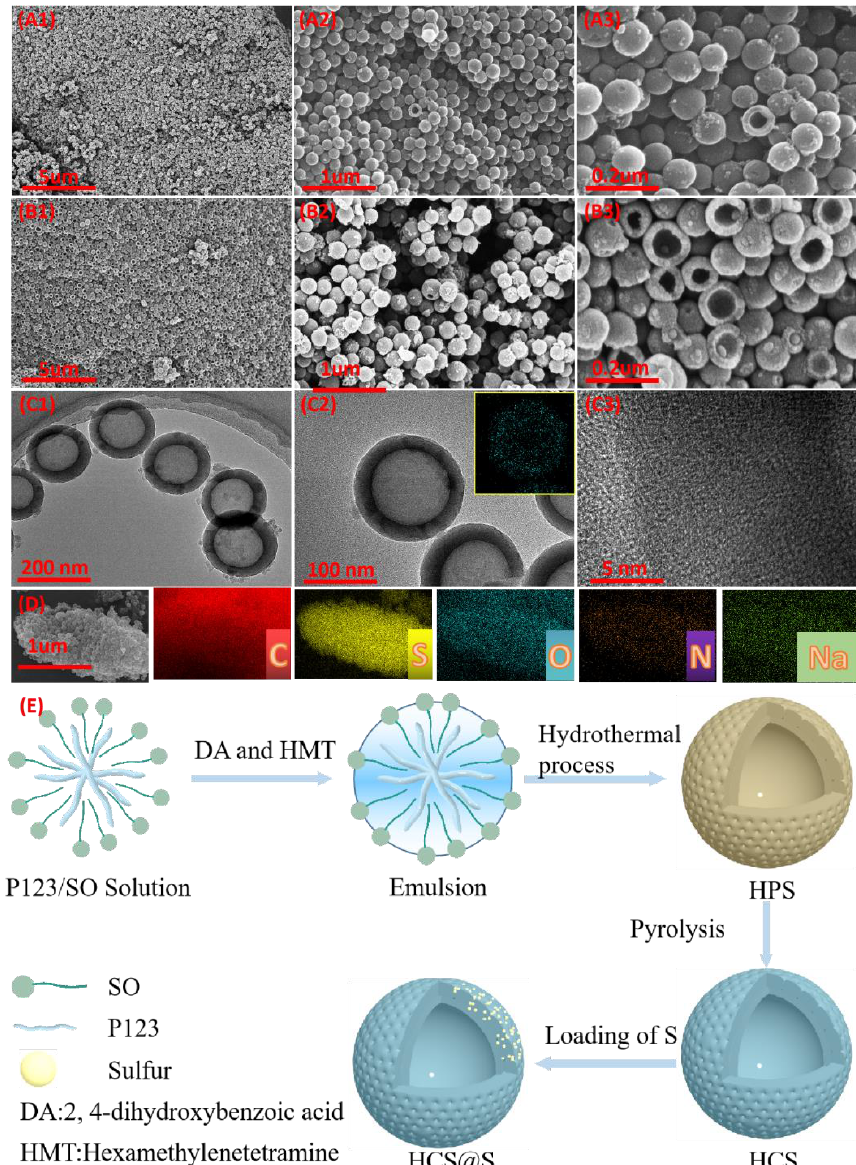
Figure 3. The exploration of their morphology: SEM images of HCS ( A ) and HCS@S-H ( B ), TEM images and mapping images of HCS@S-H ( C , D ) and the preparations process of HCS and HCS@S ( E ). Driven by the significant structural design, the relative electrochemical properties were carried out. Firstly, it could be found that the designed HCS@S-H samples